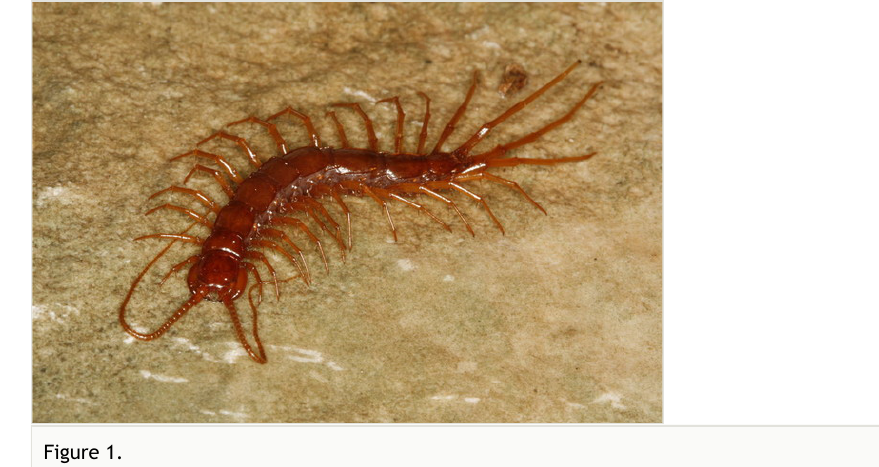
Figure 1. Habitus of Eupolybothrus cavernicolus Komerički & Stoev sp. n., male paratype, ex